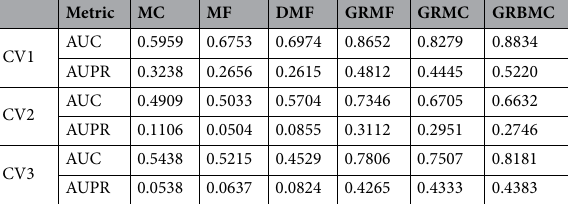
Table 1. Results for association prediction for all techniques under the 3 cross validation